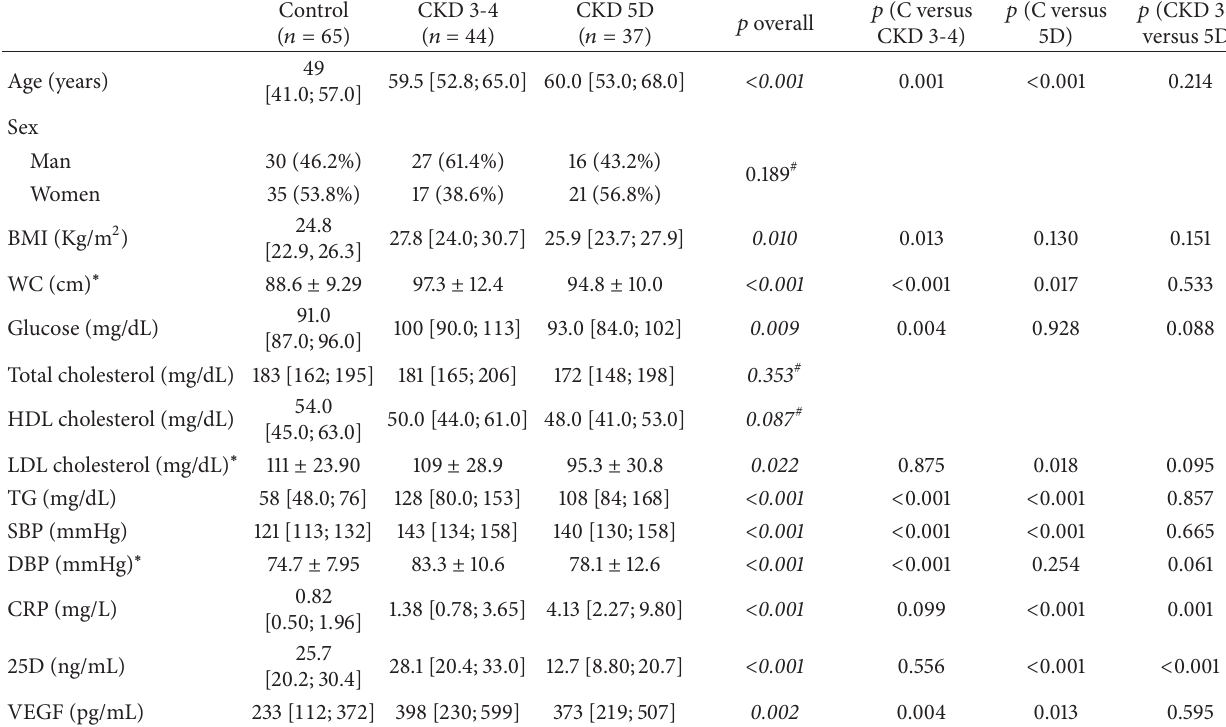
Table 1: Baseline characteristics of the study populations.